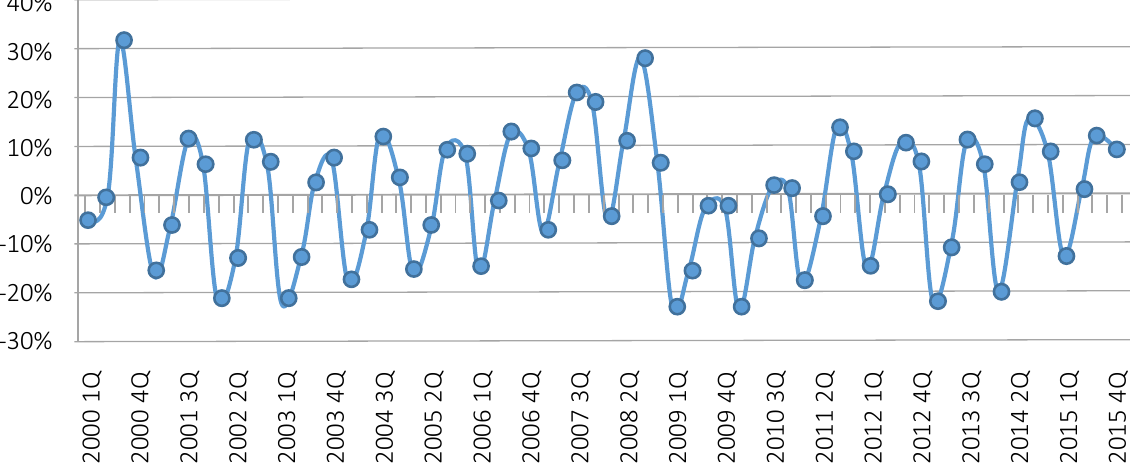
Figure 10. Quarterly GDP gap estimated by HP filter